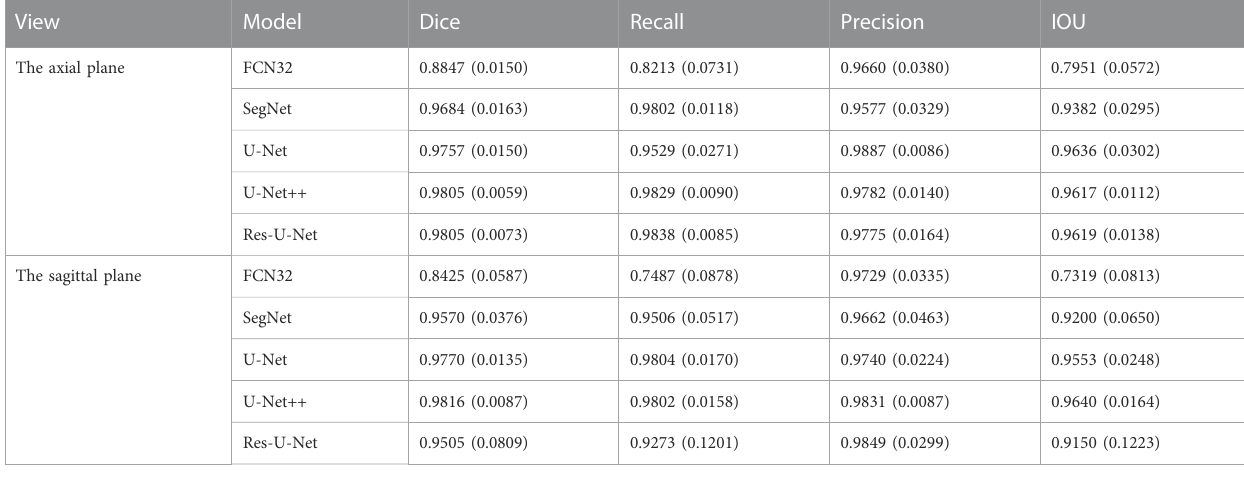
TABLE 1 The mean values (standard deviation) of the Dice Coef fi cient, IOU, Precision, Recall for segmenting the ocular region model in the axial plane and the sagittal plane of the CT images, respectively. View Model